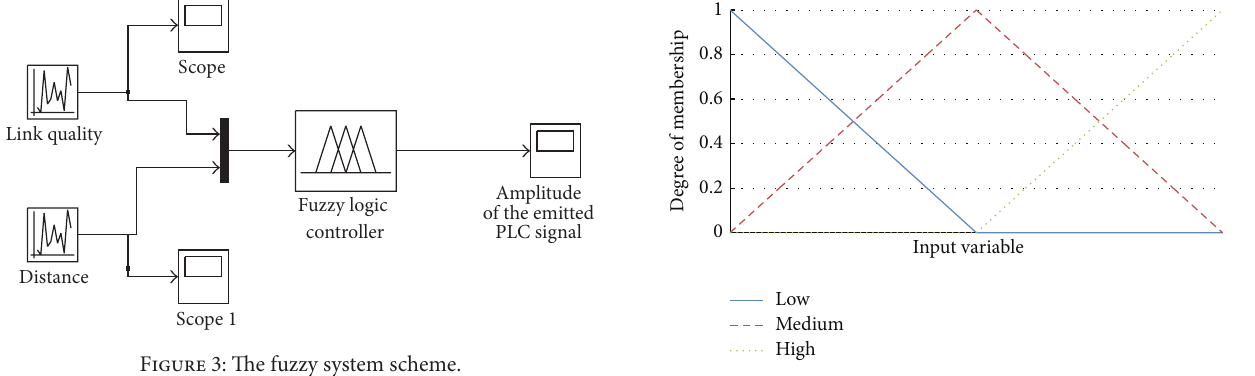
Figure 4: Input variables membership functions